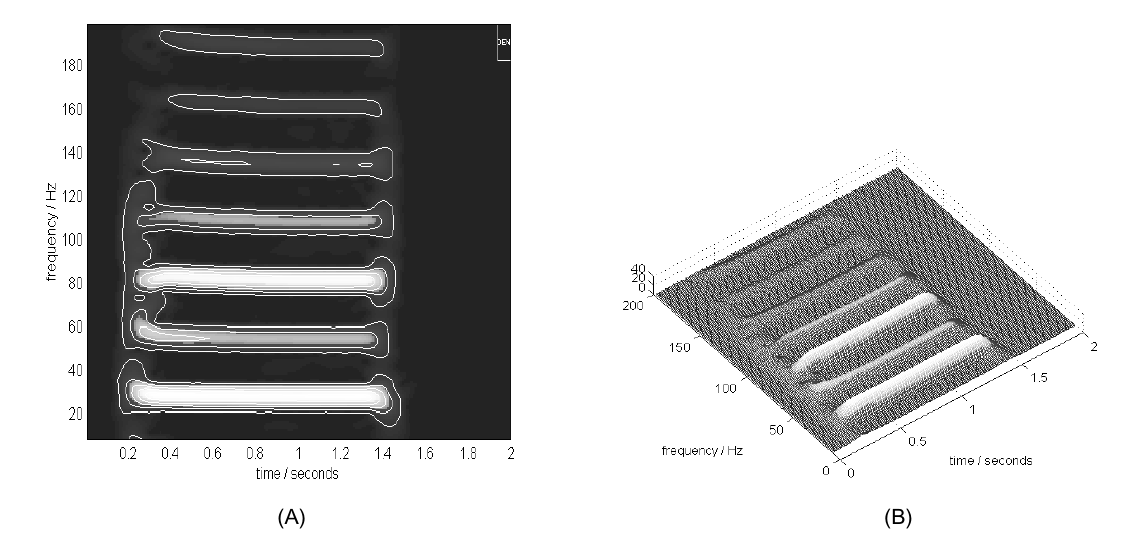
Fig. 8. (A) Time-frequency map of the changing frequency composition of the bottom signal, (B) Corresponding mesh diagram for the contour plot in Fig. 8(A).